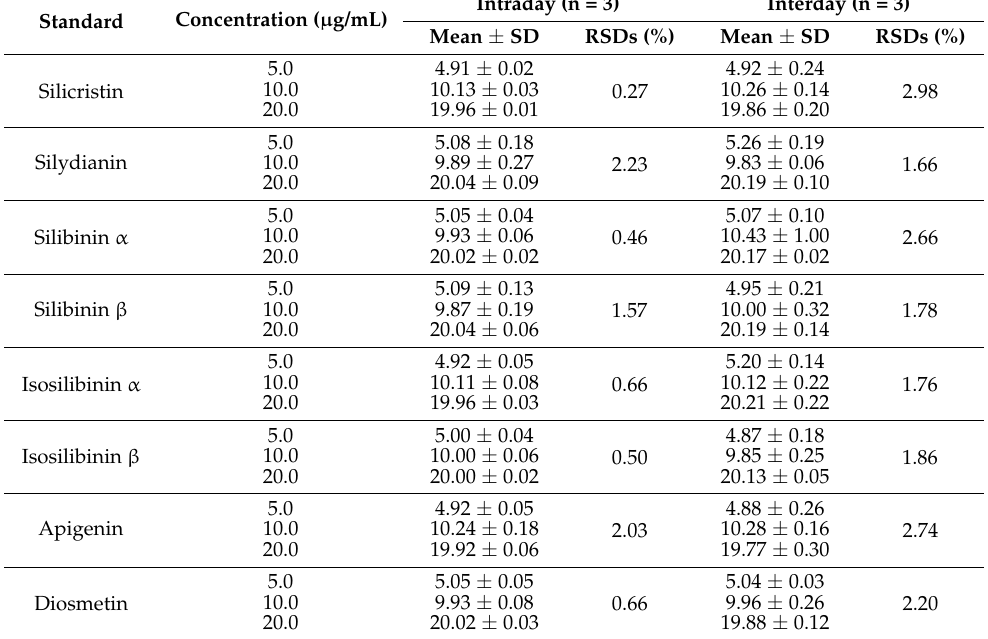
Table 3. Intraday and Interday Variabilities of All Standards.